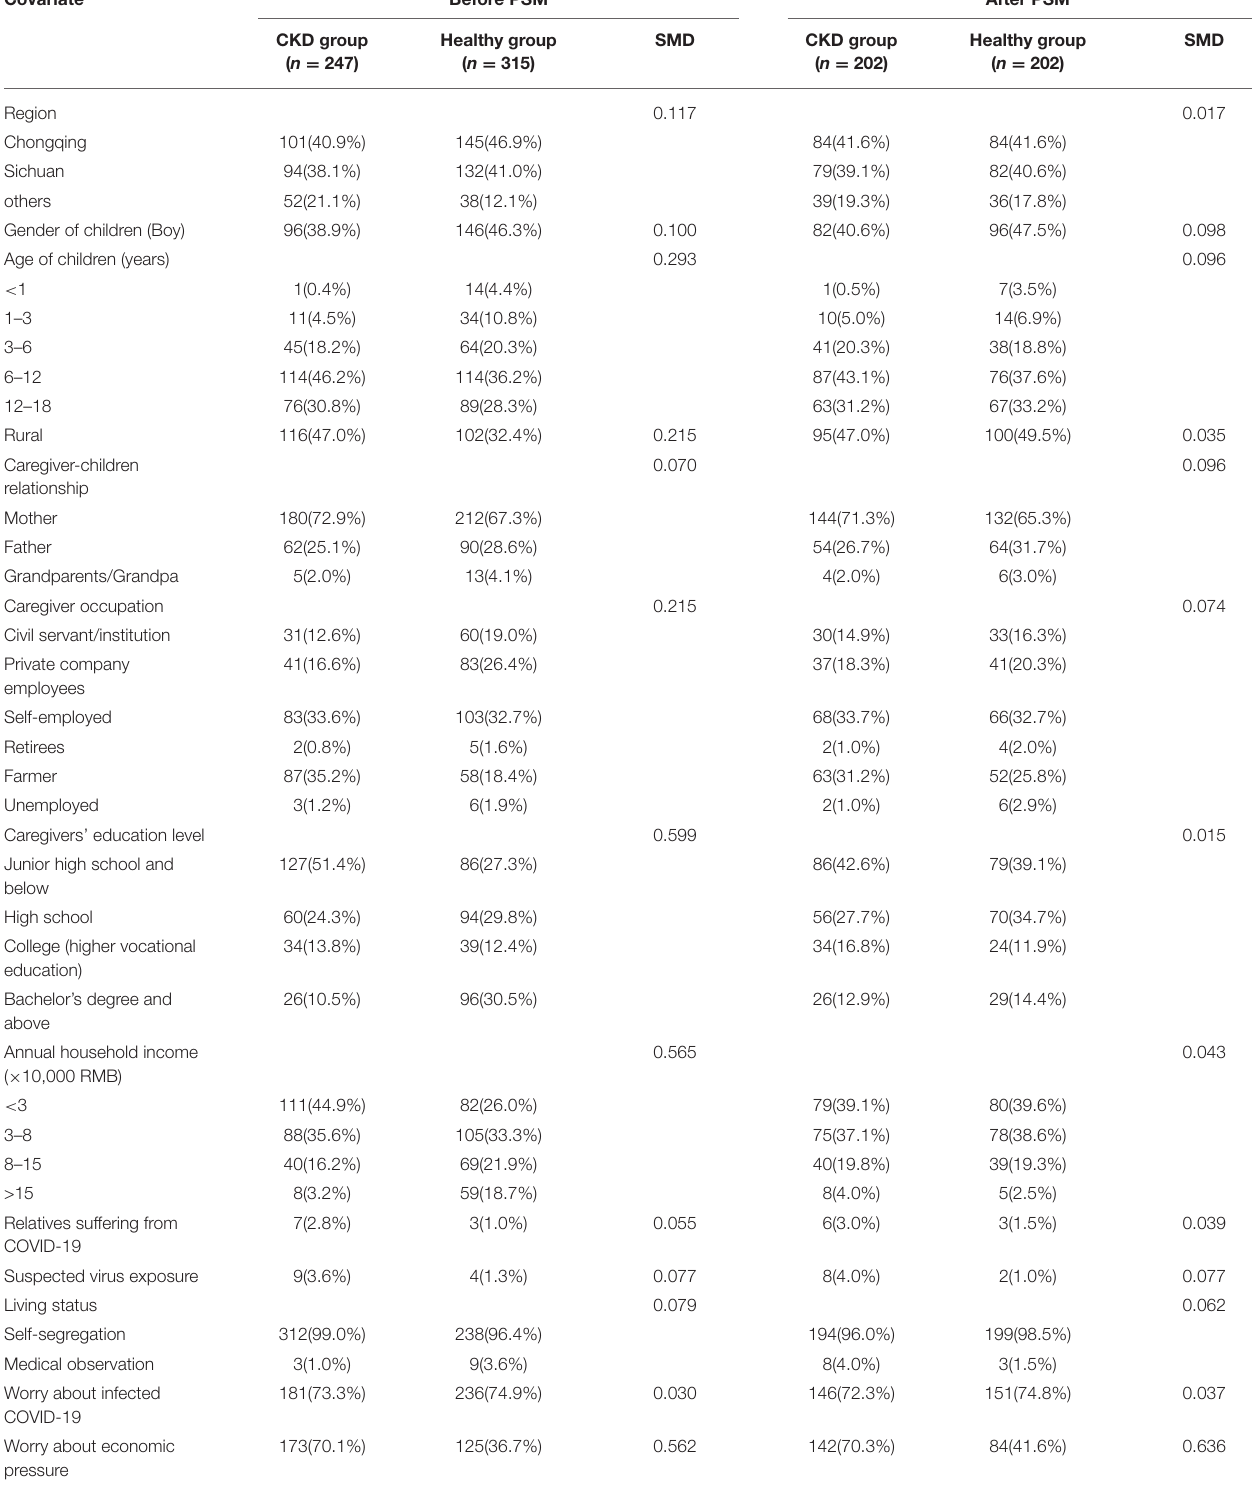
TABLE 1 | Comparison of baseline data between the observation group and control group before and after PSM. Covariate Before PSM After